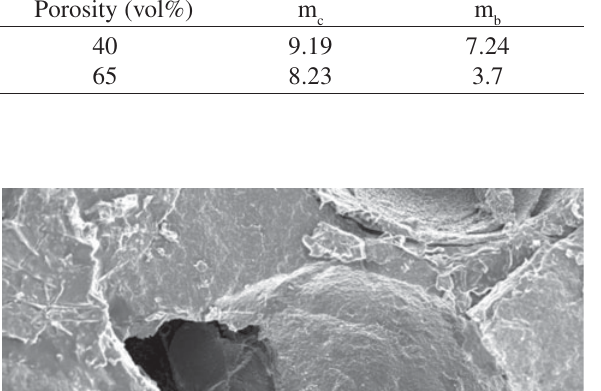
Figure 3. Probability of failure of porous GR-HA discs vs. bend- ing